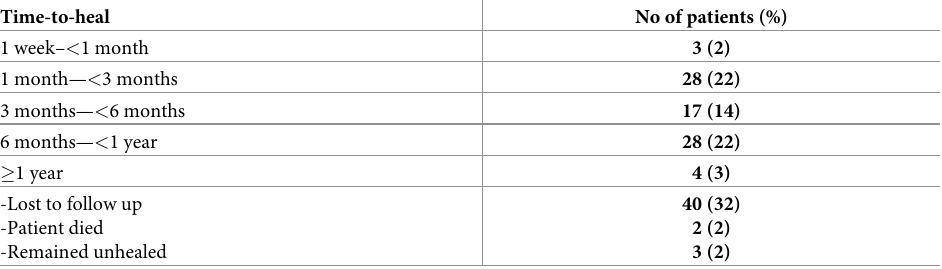
Table 6. Time-to-heal of diabetic foot ulcers.